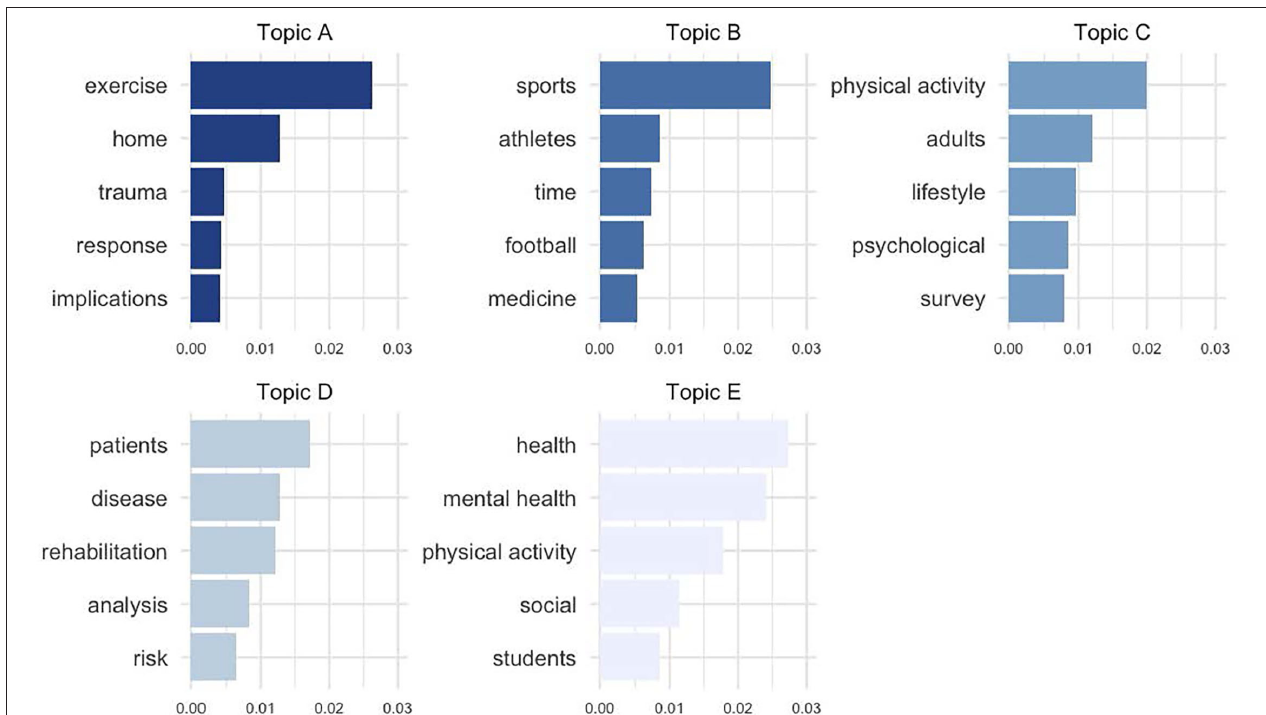
FIGURE 2 | Topic analysis of articles related to PA, sport, and exercise. Results of the statistical topic analysis conducted on the titles of the 1,903 identified articles that have been published in the first 365 days of COVID-19 pandemic as declared by WHO. The analysis suggested five topics, each delineated by the five words/terms shown. Numerical values on x-axis are beta values which are the probability of a term/word generated from that topic as computed by the